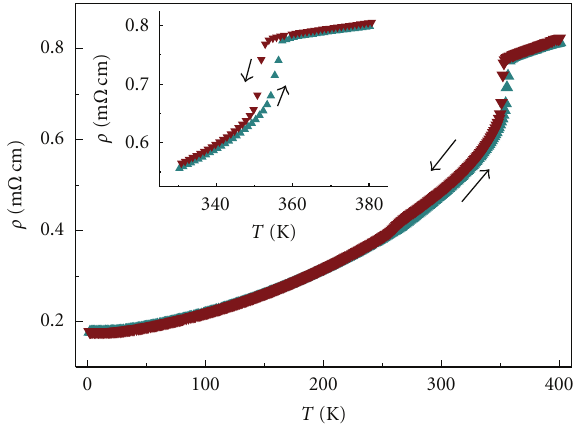
withtemperatureforMn 𝜌𝜌